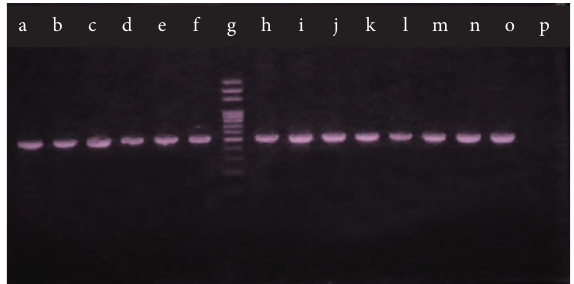
Figure 3: Agarose gel (1%) electrophoresis of PCR assay of the oprL gene (504 bp). a b, c d, e f, h i, j k, l m, n, and o: oprL -positive P. aeruginosa isolates, g: 100bp marker, o: positive control, and p: negative control (nuclease-free water).